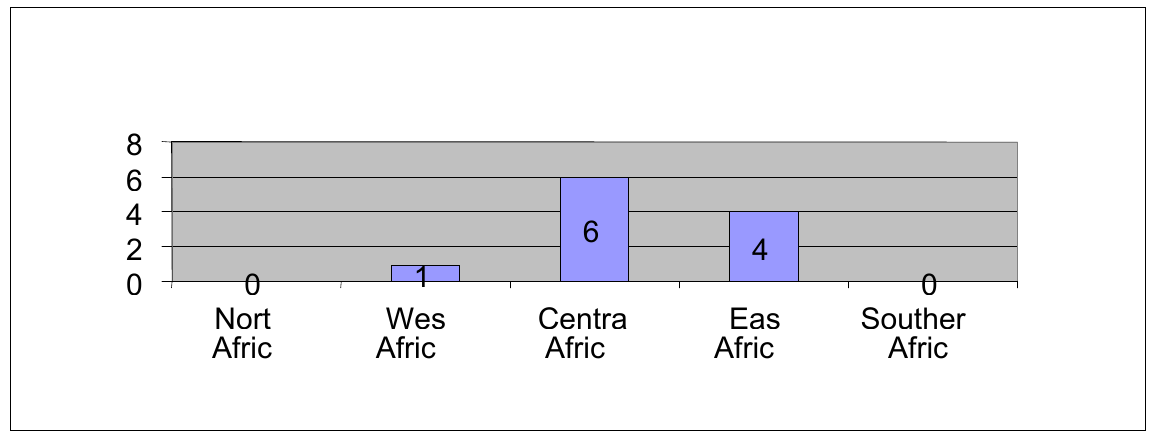
Figure 6: Volcanic related disasters in Africa: 1974 to 2003